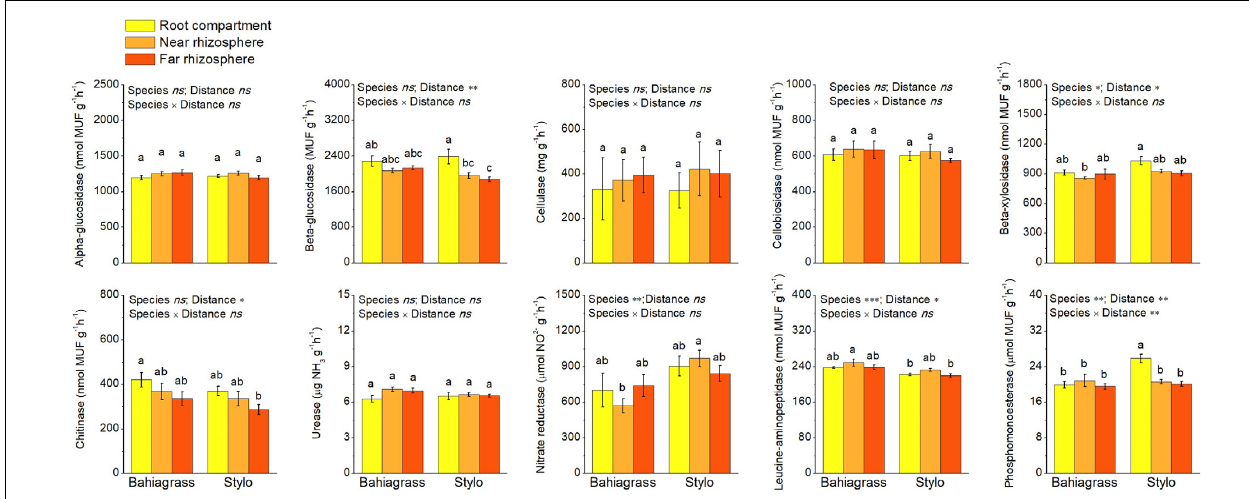
FIGURE 4 | Soil enzyme activities as affected by plant species and distance. Bars with different letters are significantly different (Tukey HSD test, P < 0.05). Near rhizosphere and far rhizosphere indicate the rhizosphere space of 0–5 mm and 10–15 mm apart from rhizoplane, respectively. Bahiagrass, Paspalum natatum ; Stylo, Stylosanthes guianensis